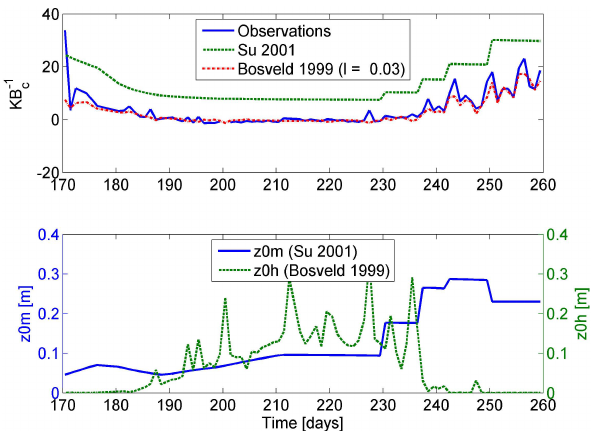
Fig. 5. Top panel: seasonal variation in the daily kB − 1 values for the maize canopy calculated from observations, the parameteriza- tions by Su (2001) and Bosveld et al. (1999). In the bottom panel the roughness length for heat and momentum is shown for Su (2001) and for the new kB − 1 parameterization. The new values of the roughness length for heat, are calculated using the k − 1 parameteri- zation of Bosveld (1999), and the roughness length for momentum by Su